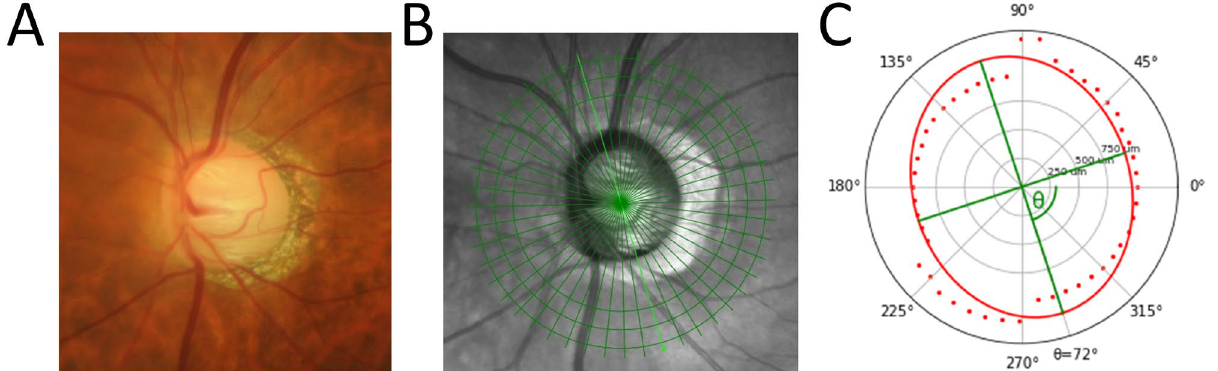
Figure 2. Case illustration of BMO ovality index (0.82) and BMO rotation angle (72.4°) measurement in a highly myopic left eye (AL = 26.1 mm). The photograph ( A ) and OCT infrared image ( B ) of the optic disc are shown on the left and the corresponding BMO ovality and rotation measurement ( C ) is illustrated on the right image. The red dots indicate the BMO points. The red ellipse represents the fit ellipse based on the BMO points. The green vectors indicate the shortest and longest diameter of the BMO ellipse and are defined as major and minor axis to calculate the BMO ovality index. The BMO rotation angle is defined as the angle between the semimajor axis and the temporal axis (0°, horizontal axes of the en face OCT image), adjusted for variation in individual anatomies based on the FoBMOc angle. Abbreviations: BMO, Bruch’s membrane opening; FoBMOc, Fovea BMO center; OCT, optical coherence